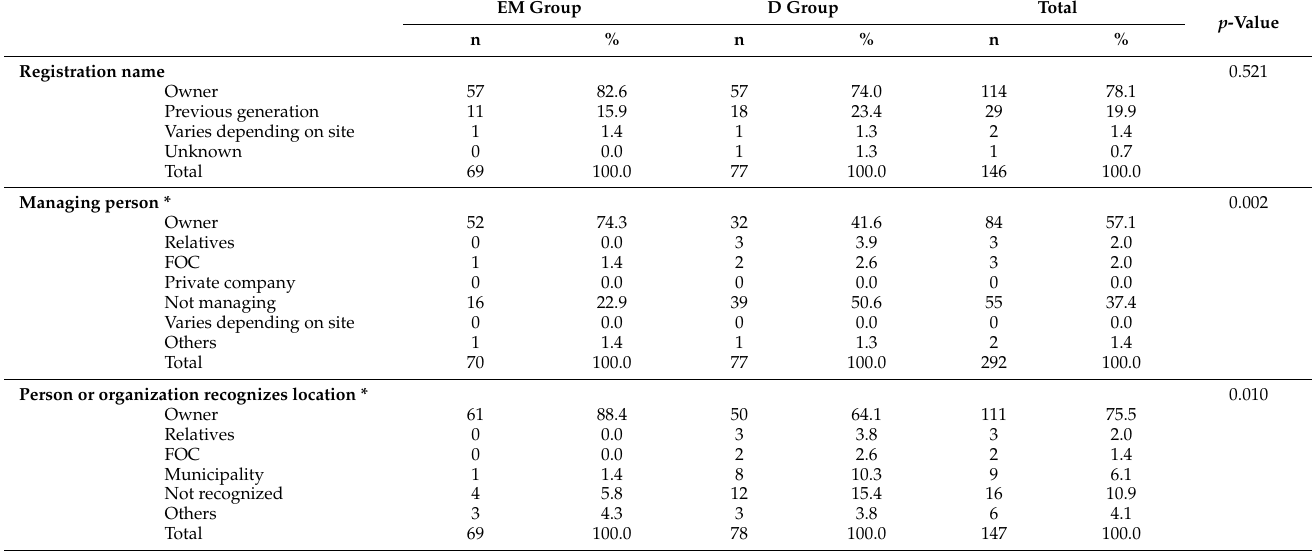
Table 6. Comparison of forest management behaviors between the two groups in